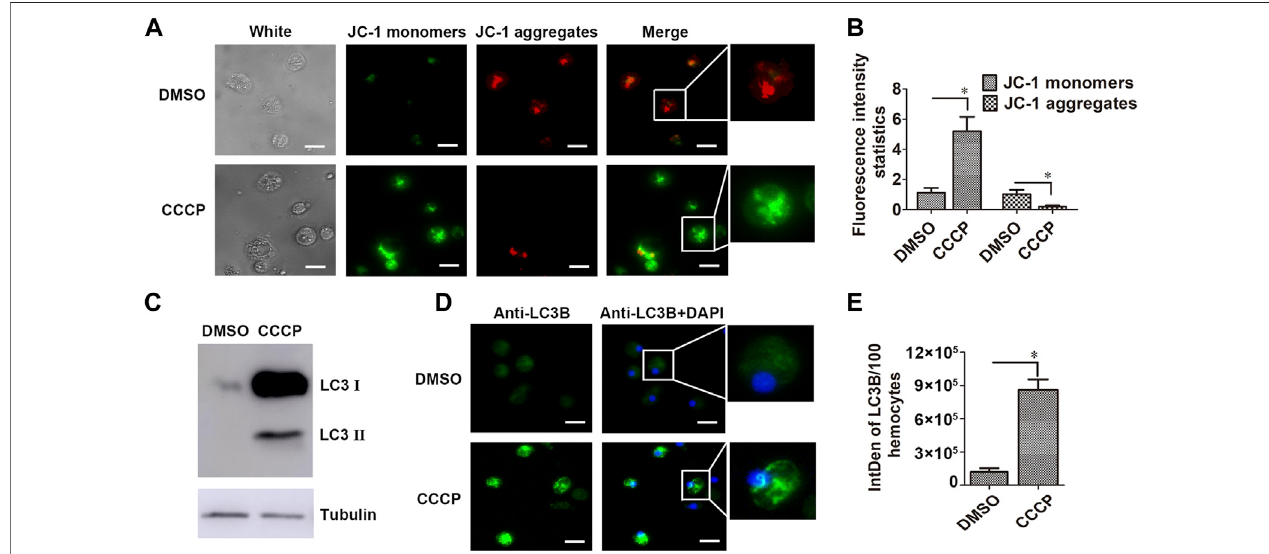
FIGURE 5 | Mitochondrial membrane potential and Cg LC3 activation in CCCP-treated hemocytes. (A) Mitochondrial membrane potential in CCCP-treated hemocytes. DMSO was used as the control. (B) Statistical analysis of the JC-1 monomer and aggregate green signals for A, respectively. (C) Cleavage of Cg LC3B in CCCP-treated hemocytes. (D) Speckled dot accumulation of Cg LC3B in CCCP-treated hemocytes. Bar: 5 μ m. (E) was the statistical analysis of (D) . Fluorescence signals were captured under the same exposure parameters. The vertical bars are shown as mean ± S.D. (N = 3). *: p < 0.05 ( t -test).